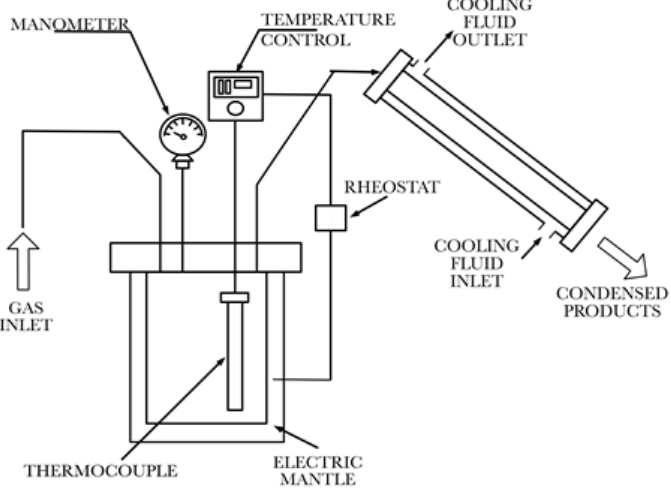
Figure 1. Pyrolysis reaction